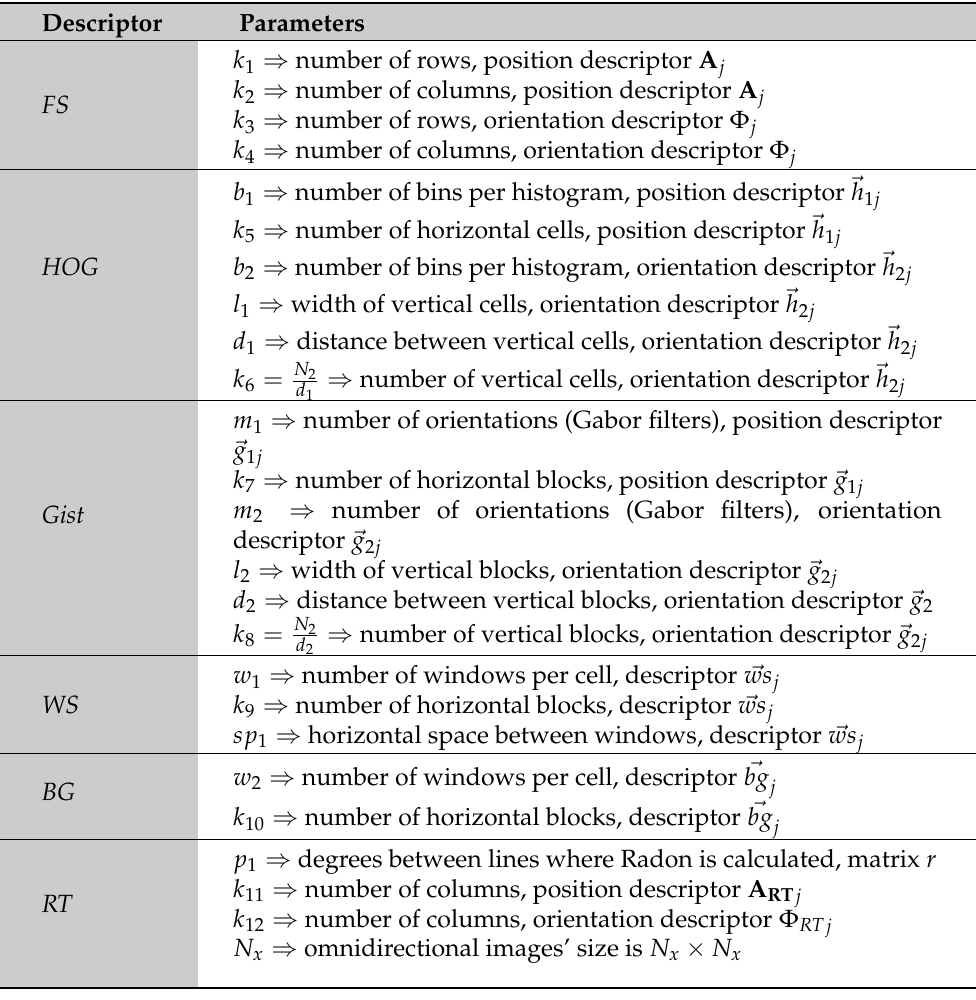
Table 1. Parameters whose influence in the localization process is